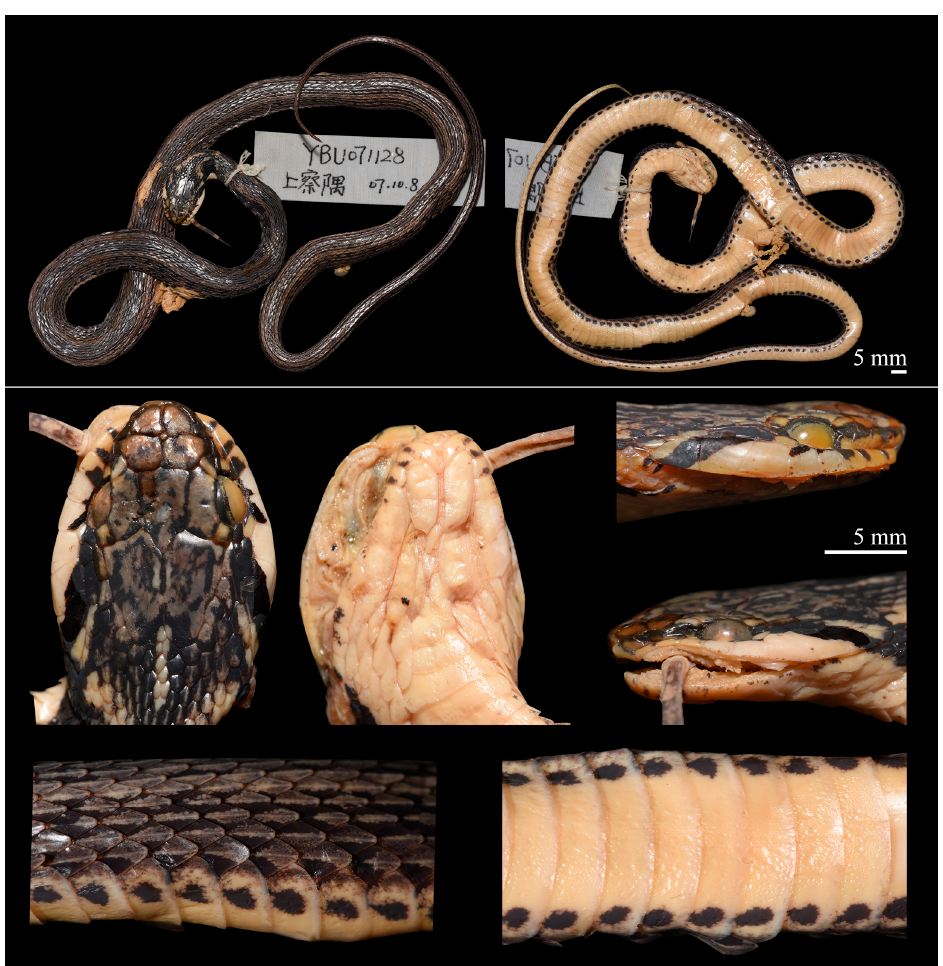
Figure 6. Preserved holotype of Herpetoreas burbrinki , YBU 071128, adult male, Zayü County, Xizang Autonomous Region, China. Photographs by Jin ‐ Long Ren.